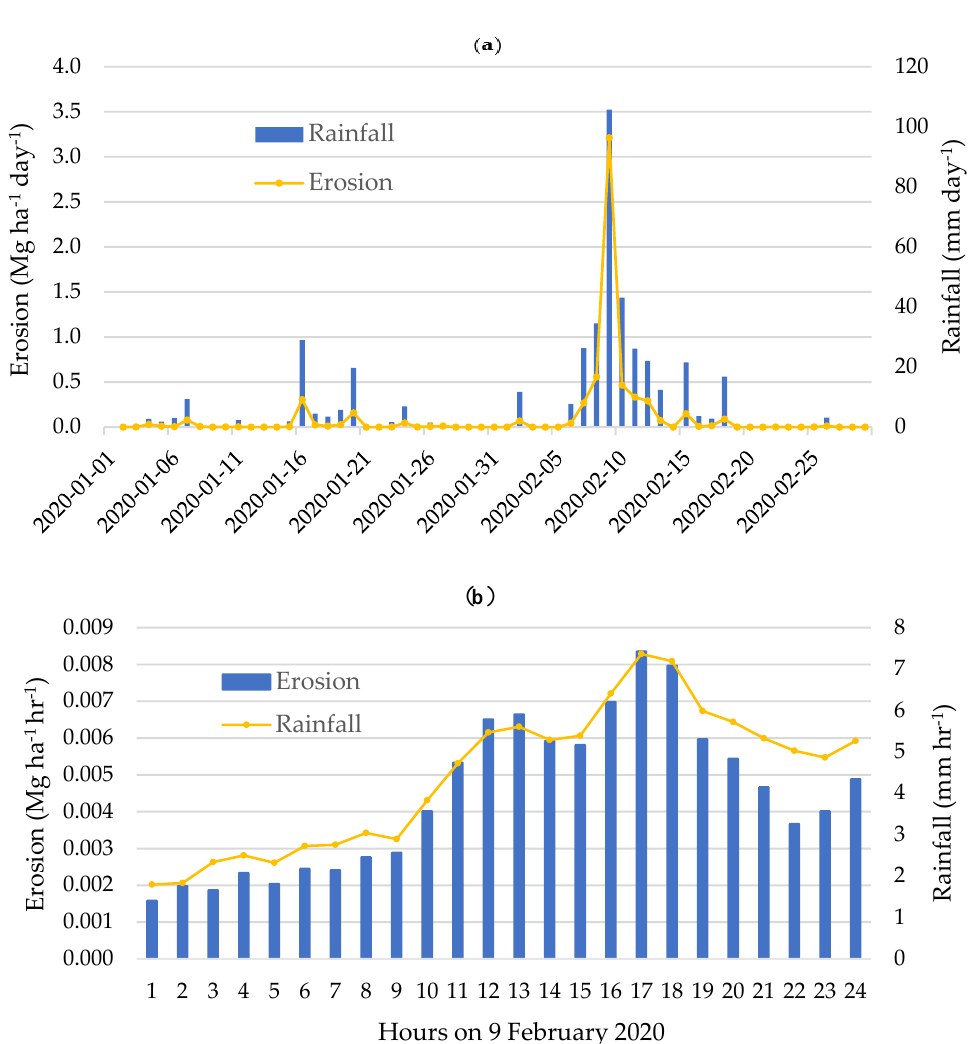
Figure 5. Estimated erosion rate from radar Rainfields data in January and February 2020 at: ( a ) daily step; ( b ) hourly step on 9 February 2020.